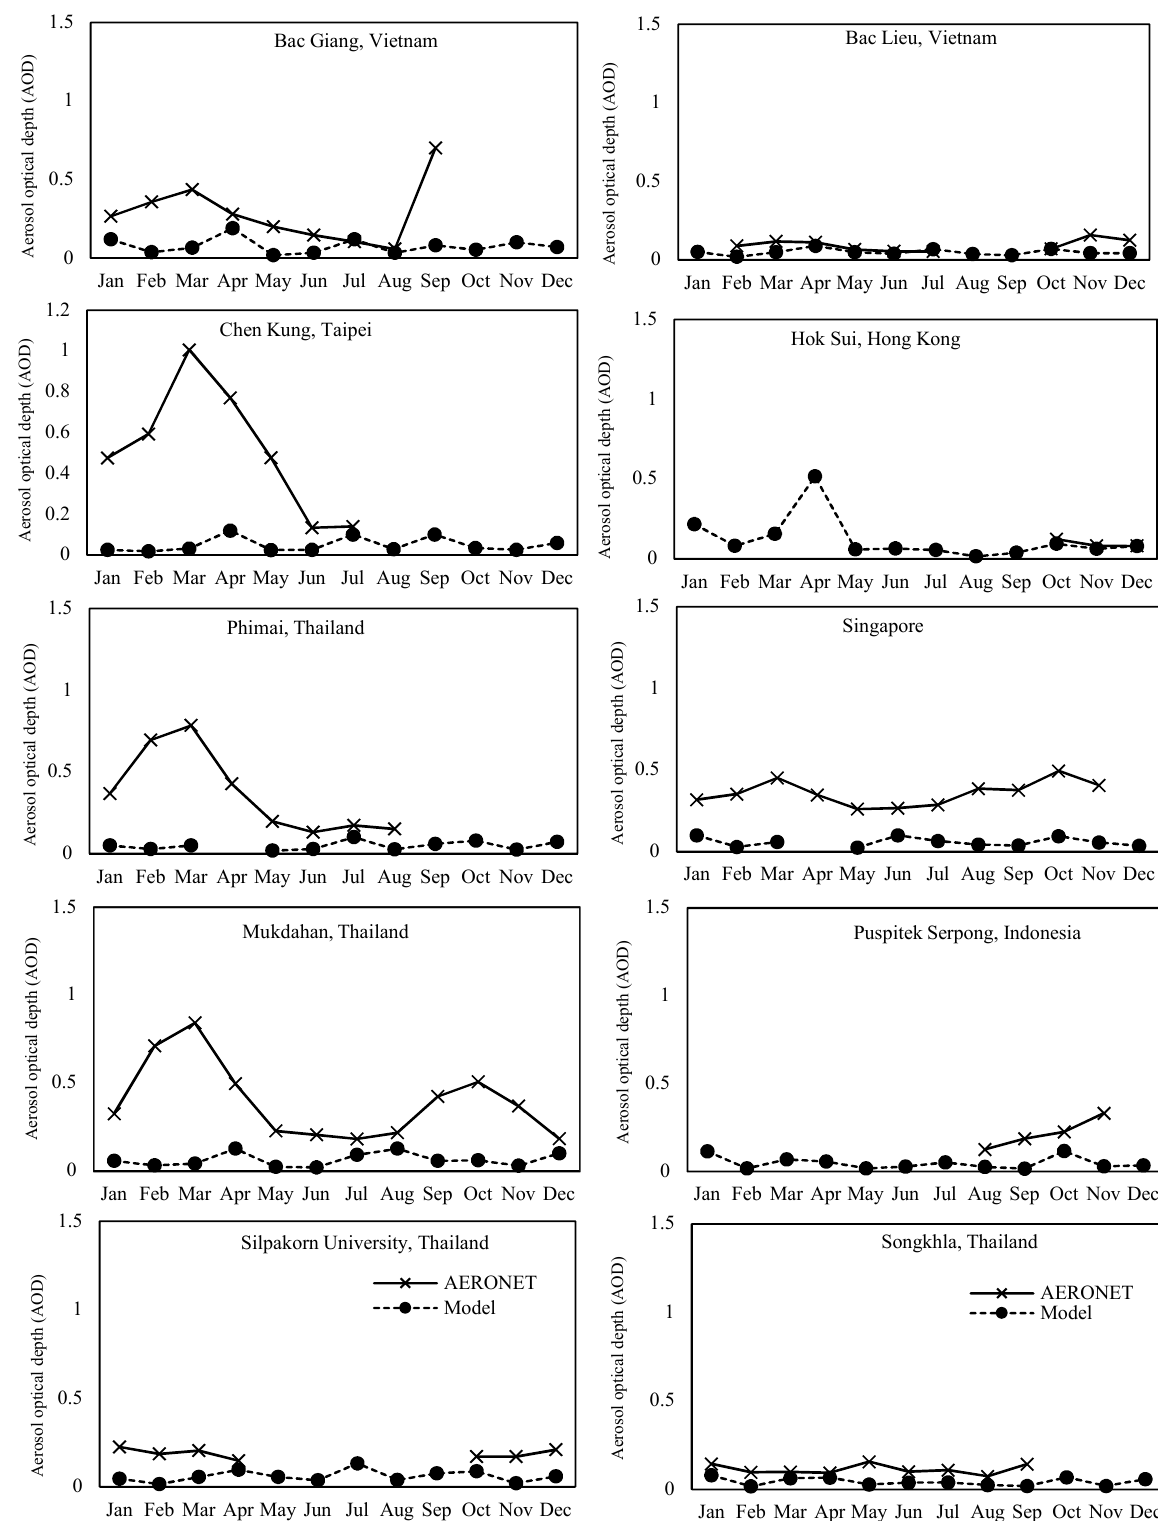
Figure 9. Monthly average of simulated vs. observed AOD at 10 AERONET stations,